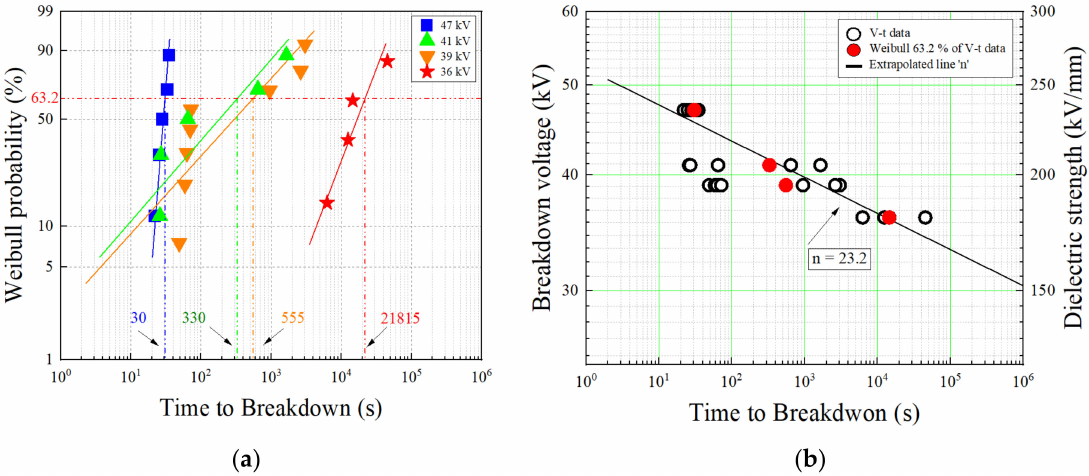
Figure 9. Breakdown data analysis on block copolymer, homo polymer and HDPE: ( a ) Weibull distribution according to time to breakdown; ( b ) V-t graph to obtain life exponent and life estimation formula.